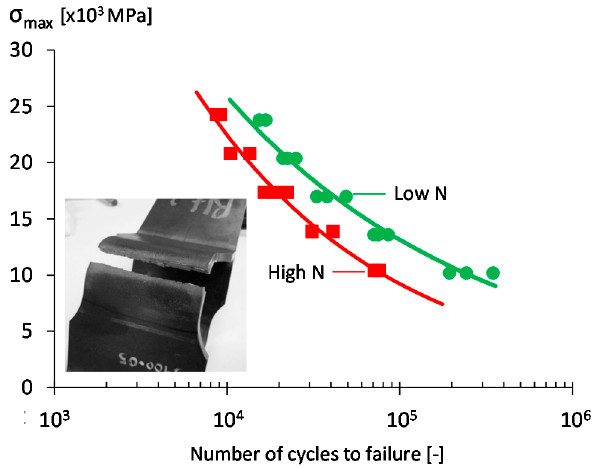
Figure 11. S–N curve obtained from cold formed specimen. The maximum stress at the bending root was calculated using a finite element model.